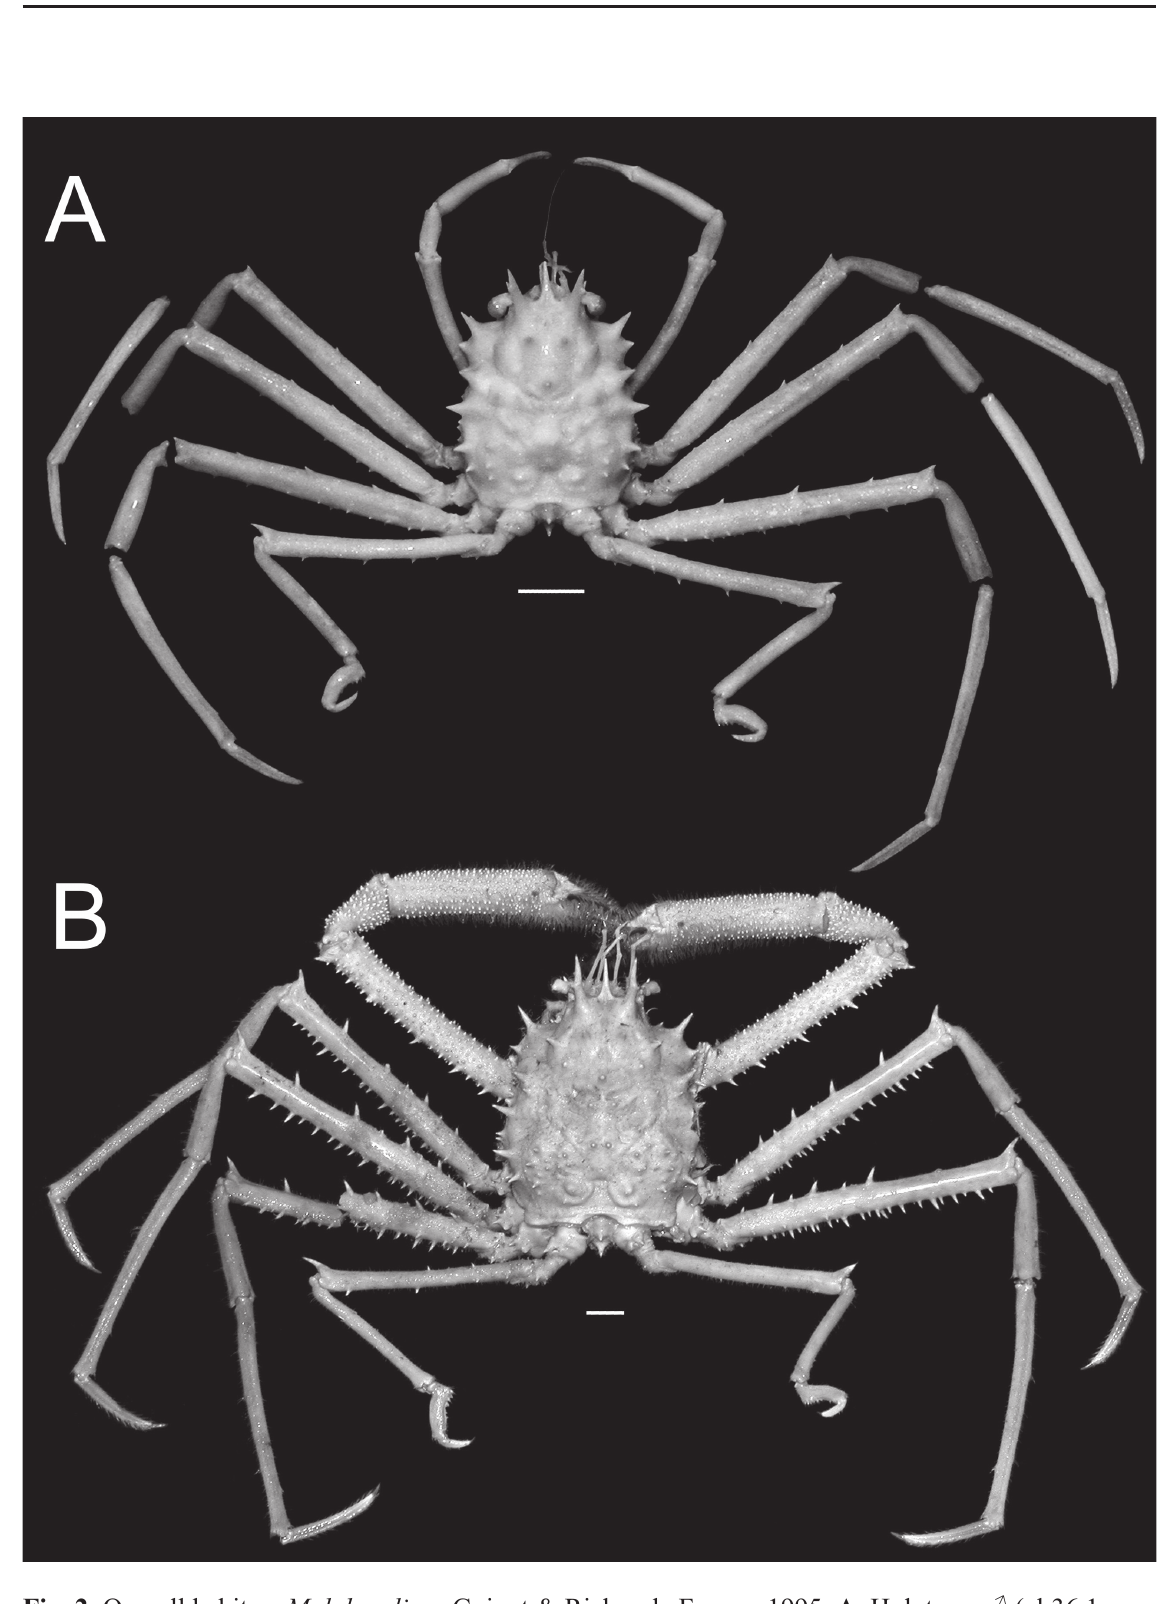
Fig. 2. Overall habitus. Moloha alisae Guinot & Richer de Forges, 1995. A . Holotype, ♂ (cl 36.1 mm, cw 29.7 mm) (MNHN-IU-2008-11077), Seychelles. B . ♂ (cl 67.5 mm, cw 56.5 mm) (ZRC 2008.1250b), South Africa. Scale bars =